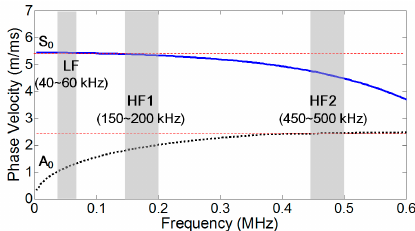
Figure 2. Phase velocity dispersion curve of the specimen: LF input was selected between 40–60 kHz, and HF input between 150–200 kHz and 450–500 kHz.